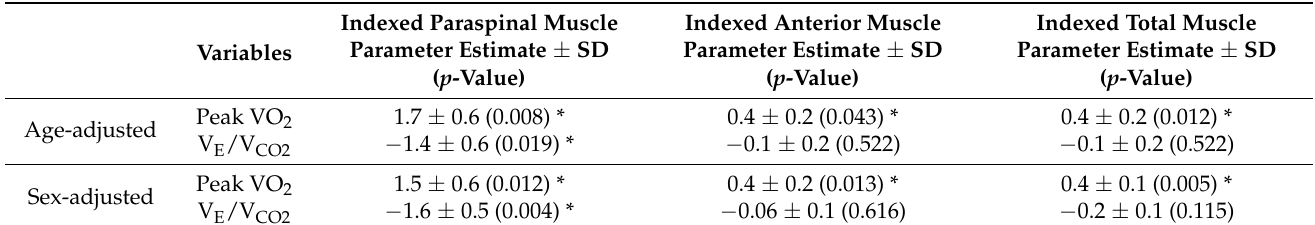
Table 6. Multivariate analysis using BSA-indexed paraspinal or anterior muscle area as one of the independent variables. Each multivariable analysis included two variables as independent variables to adjust for sex then